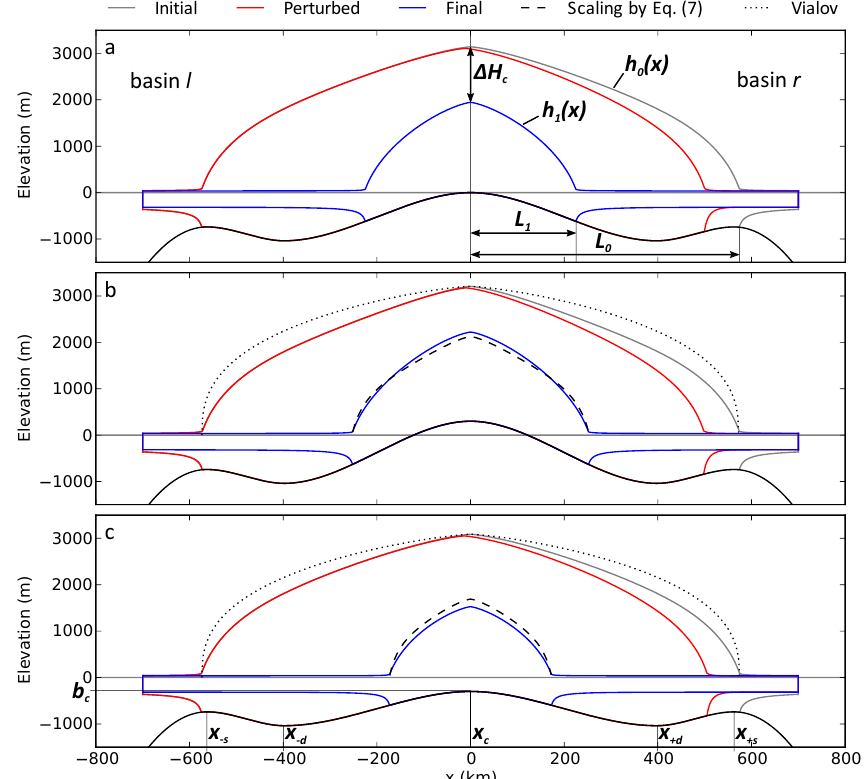
Figure 3. Ice-sheet profiles at three stages of simulation for three different values of central bed elevation (a) b c = 0m, (b) b c = + 300m and (c) b c = − 300m. Panels (a) and (c) depict the notation used in the